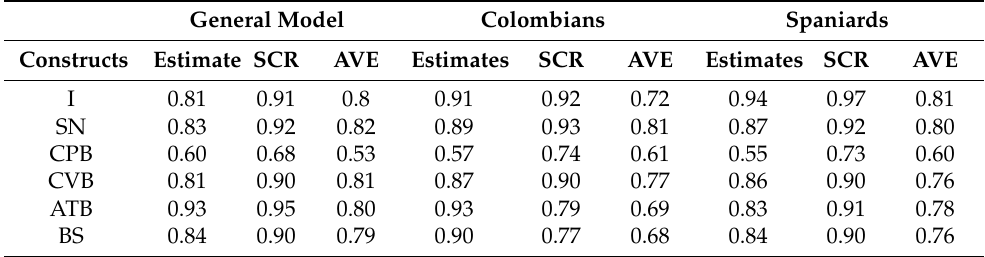
Table 2. Measurement model.